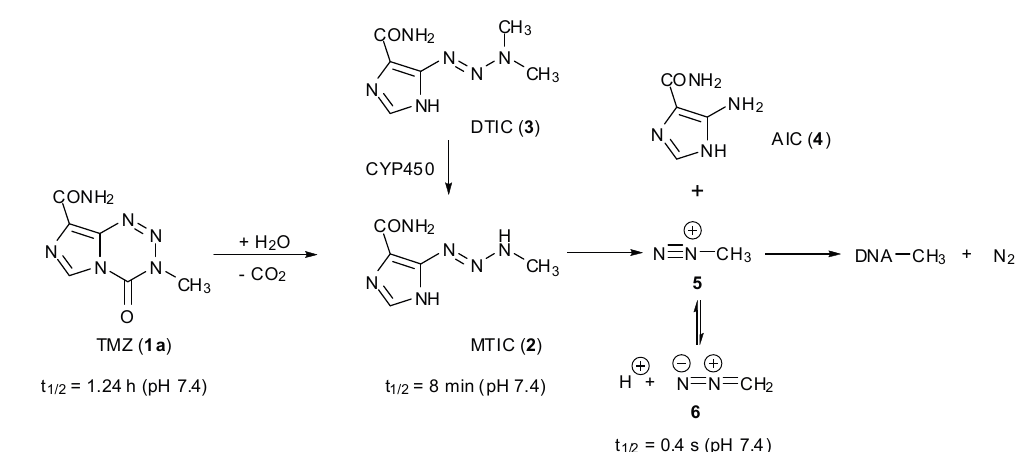
Scheme 1. Prodrug activation of